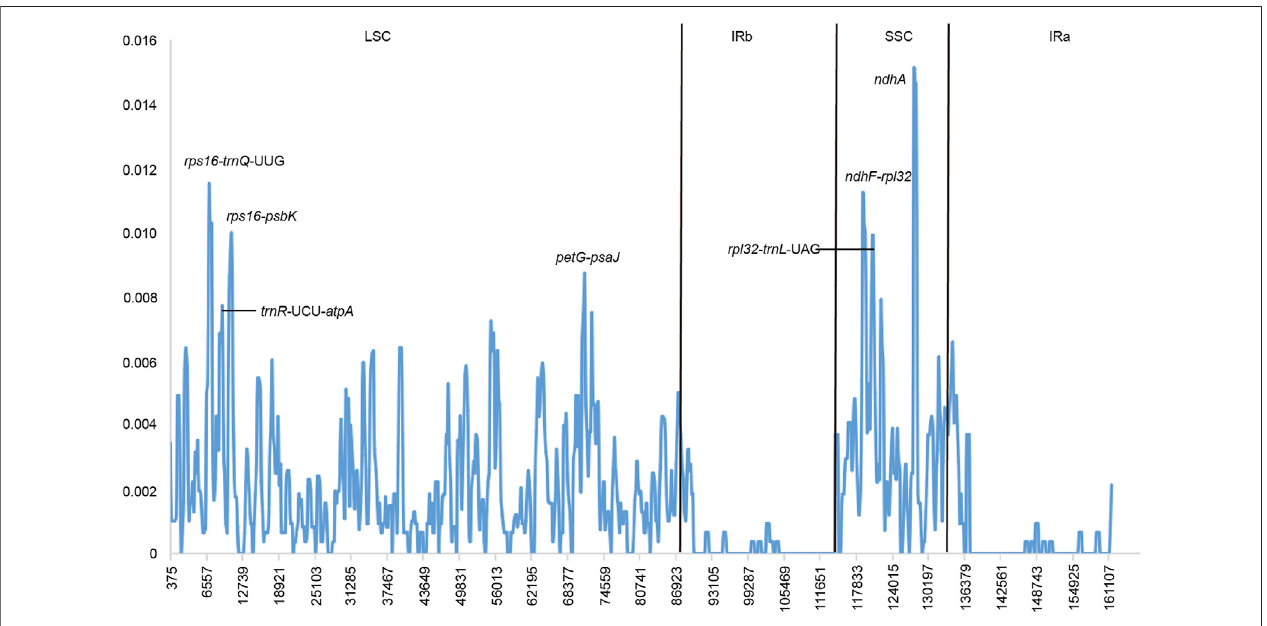
FIGURE 4 | Sliding window analysis based on the cp genomes of 9 Crataegus